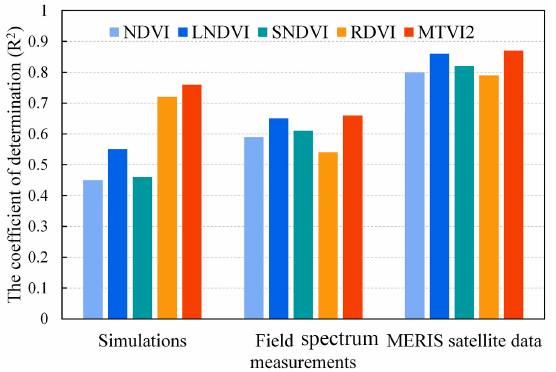
Figure 12. Coefficient of determination produced by the linear regression between the LAI and LAI-VIs—including the NDVI, LNDVI, SNDVI, RDVI, and MTVI2—from the simulation dataset, field spectra, and MERIS satellite